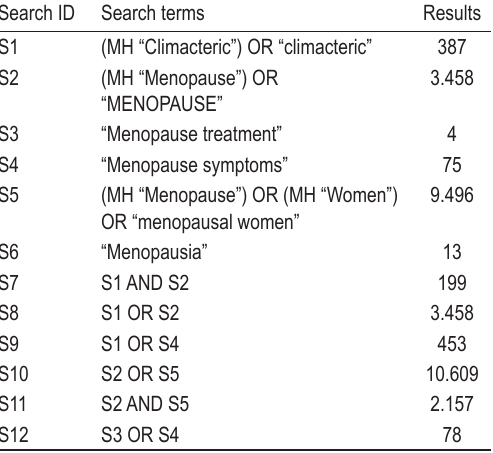
TABLE 1. Example of search strategy in the CINAHL